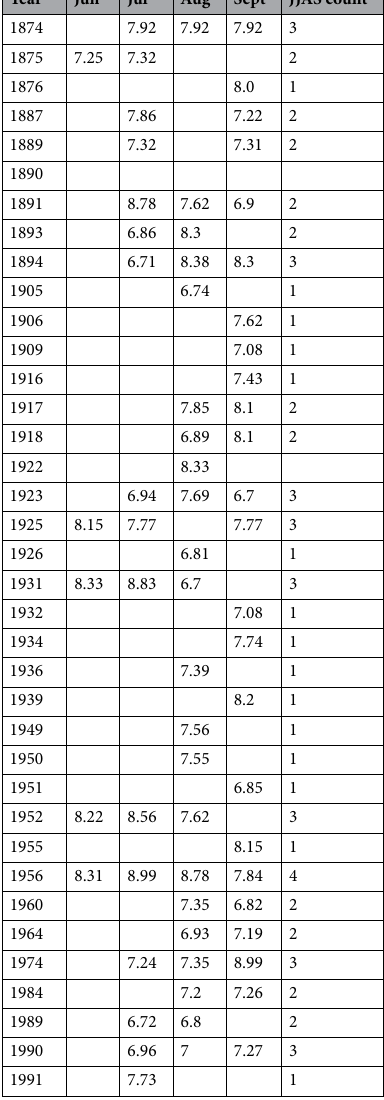
Table 1. Table showing wet season (JJAS) monthly maximum weekly Murrumbidgee River heights at Hay (southern MDB) that exceed/equal flood level (6.7 m), and seasonal count, in the 125 years 1874–2018. Note the absence of flood height exceedance values since